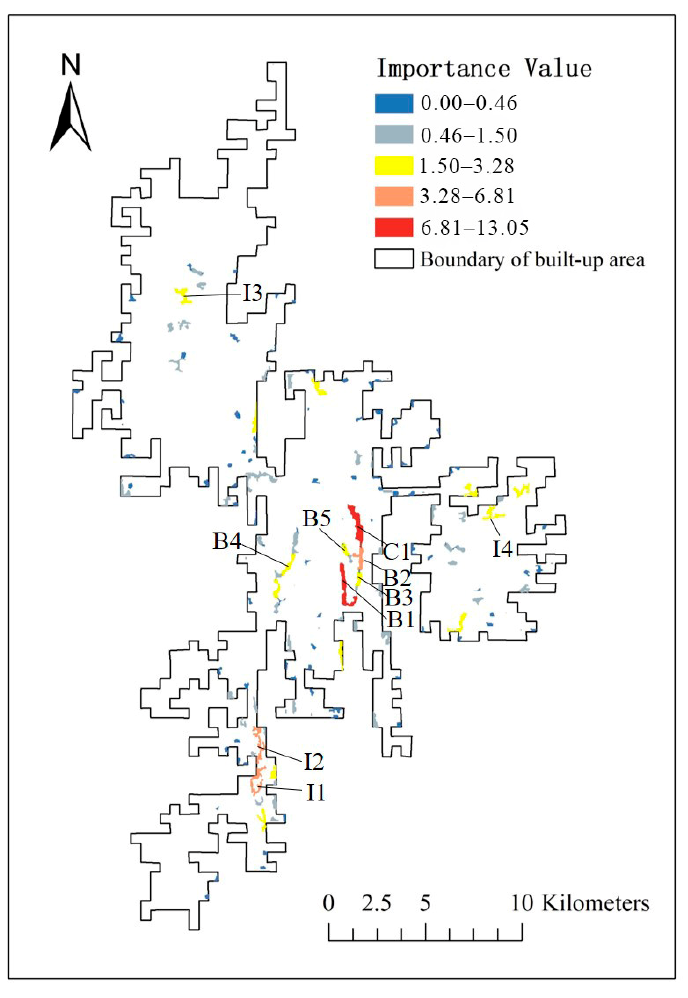
Figure 11. Probability of connectivity values of cores, bridges, and islets for historical forest patches.